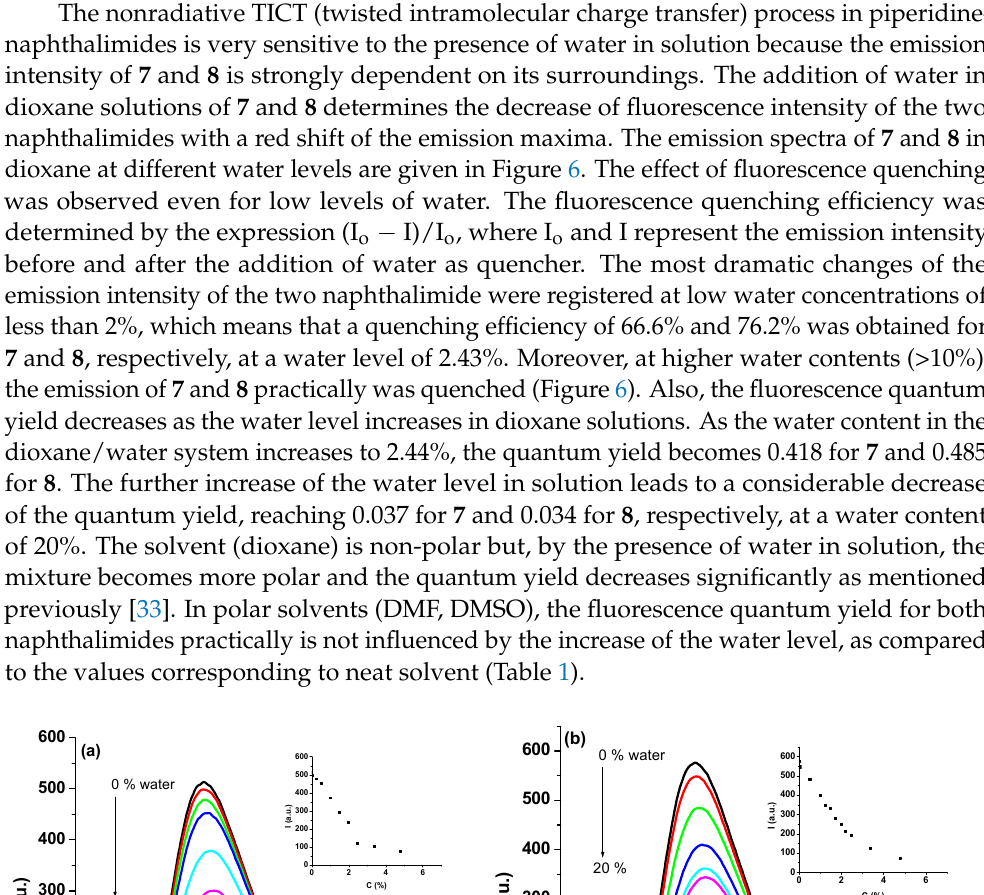
Figure 7. Changes in the electronic absorption spectra of 8 in dioxane solution as a function of wa- ter level. To explore the ability of naphthalimide derivatives to detect water in organic sol- vents, other solvents such as DMF and DMSO were utilized. Also, the emission intensity of 7 and 8 decreases progressively as the water level in solution increases, exciting with 340 or 417 nm (Figure 8, Supplementary Figures S20 and S21). It should be noticed that these derivatives show lower water sensitivity, because the estimated quenching effi- ciency values were 24.8% (DMF), and 13.1% (DMSO) for 7; and 24.2% (DMF) and 15.2%